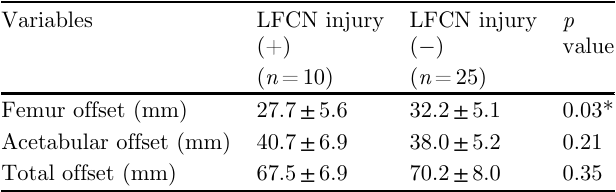
Table 2. Result of preoperative offsets of patients with and without lateral femoral cutaneous injury in Non-Fan type.